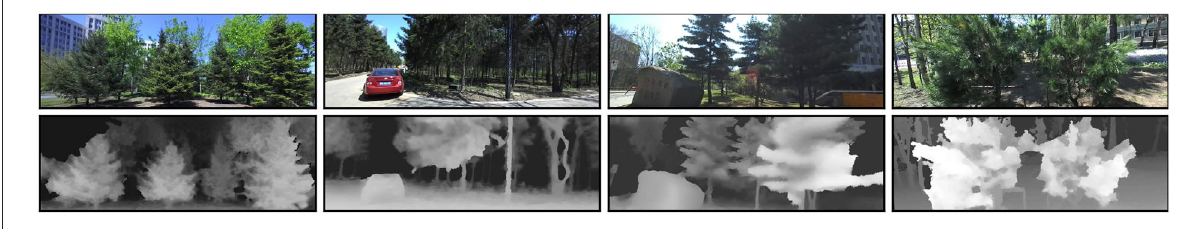
FIGURE5 Visualization of forest dataset.